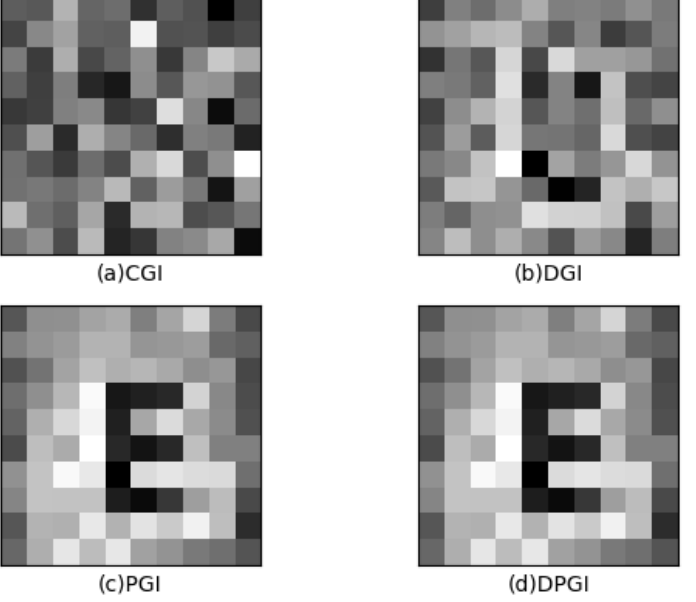
Figure 3. The results of 0.3% concentration solution in 400 measurements by four GI methods: ( a ) CGI method, ( b ) DGI method, ( c ) PGI method, and ( d ) DPGI